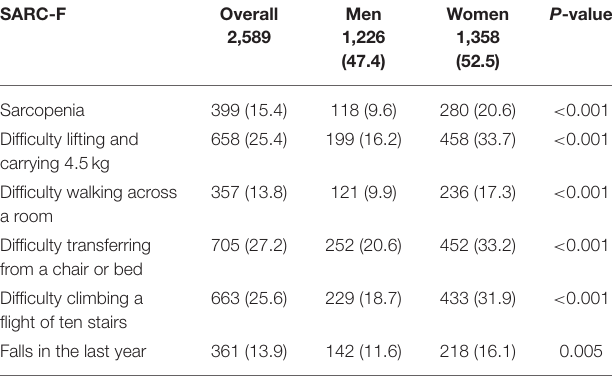
TABLE 2B | Sarcopenia and